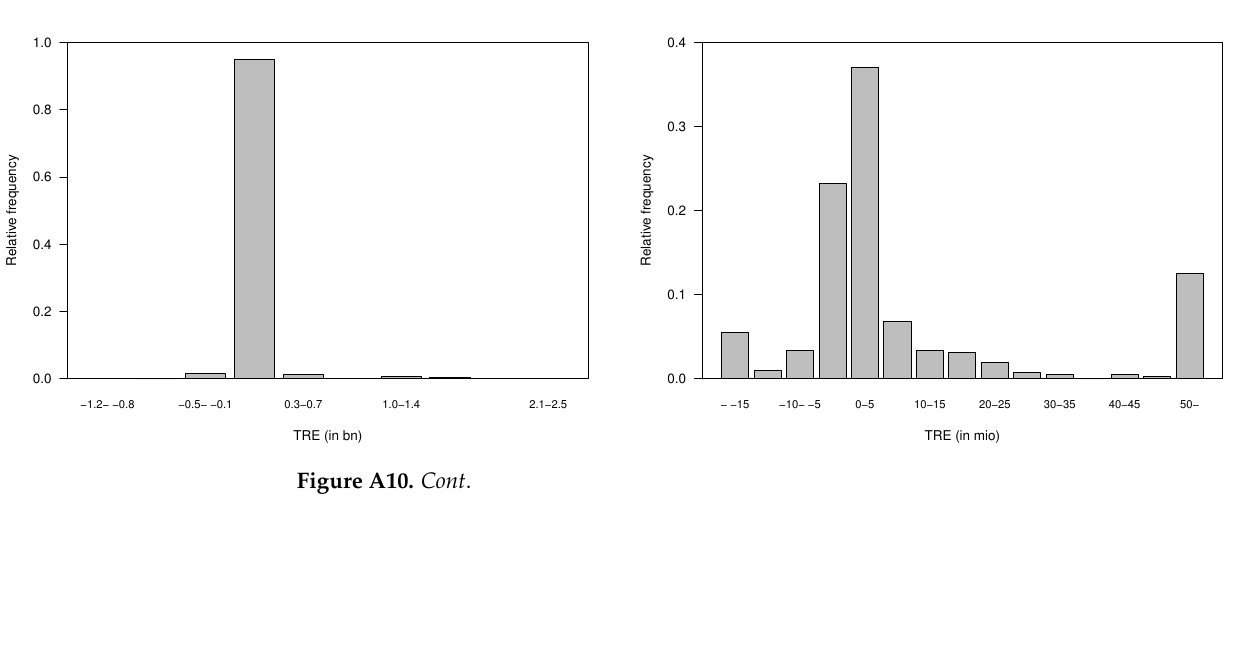
Figure A10. Cont